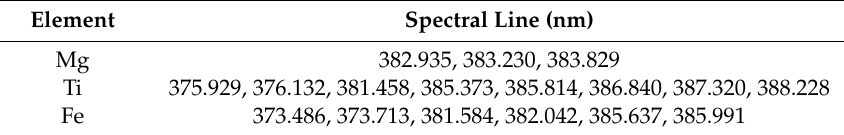
Table 3. List of strong element emission lines for Mg, Ti, and Fe from the slag samples.